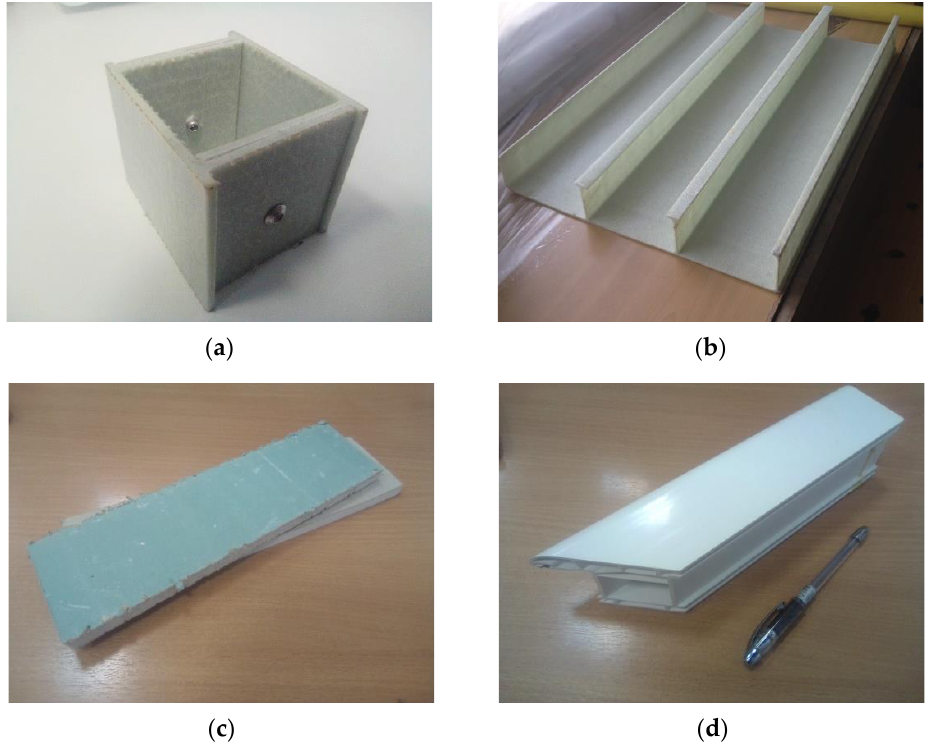
Figure 3. Samples of construction materials used for building the pavilions at the Gyulagarak magnetic observatory: ( a ) A fragment of two C-shape channel bars, joined with aluminum rivets; ( b ) plastic envelope for filling with polypropylene and mineral wool for thermal insulation; ( c ) pumice block fragment; ( d ) plastic profile for a window frame for the absolute pavilion.